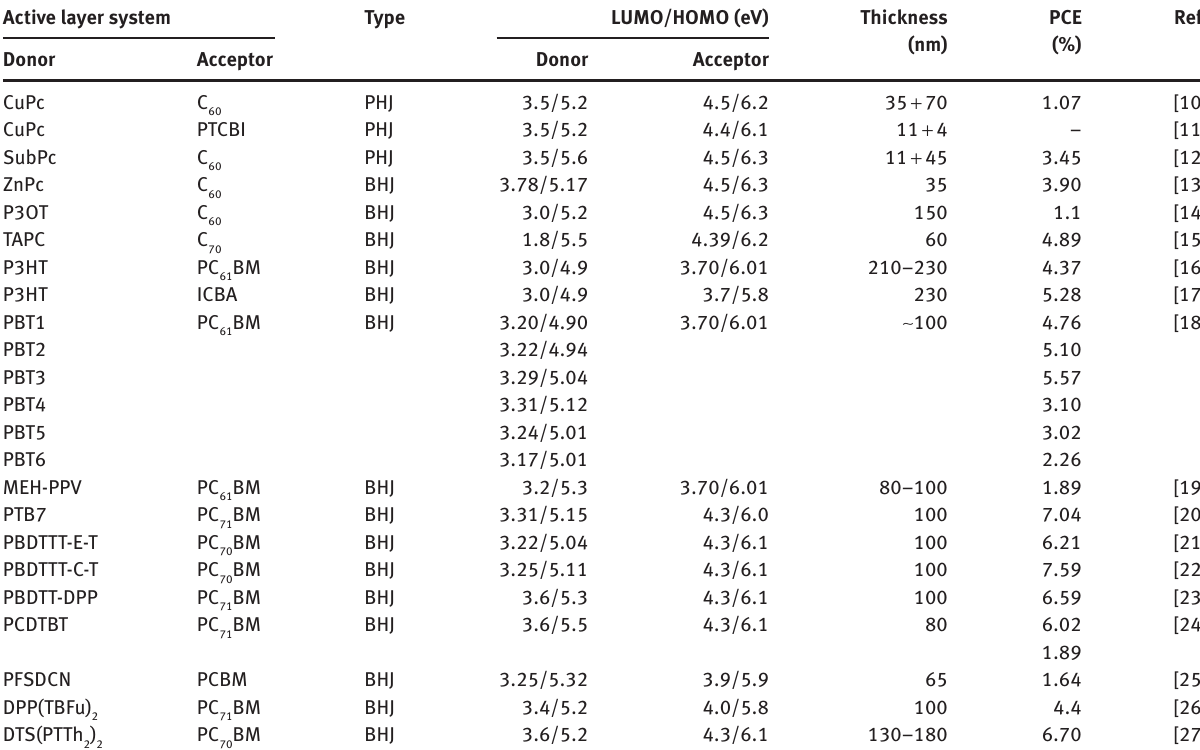
Table 1: The commonly used photoactive systems in OPVs.